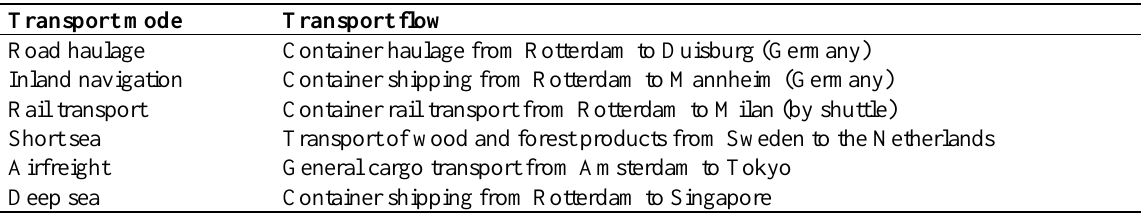
Table 2. Transport flows examined in the Delphi survey Transport mode